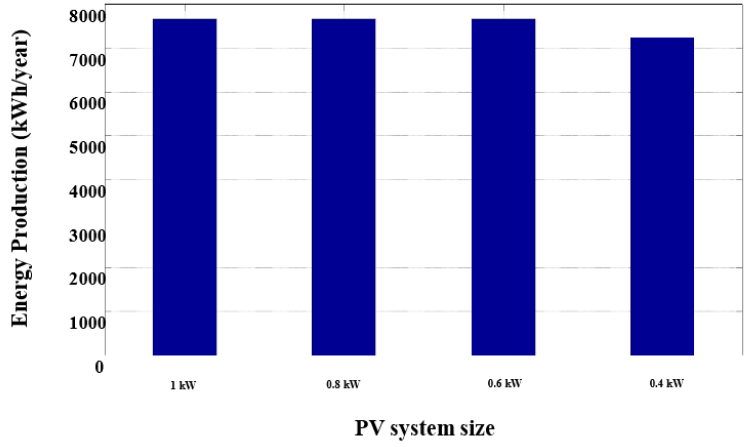
Figure 10. Energy production of different sizes of PV systems.